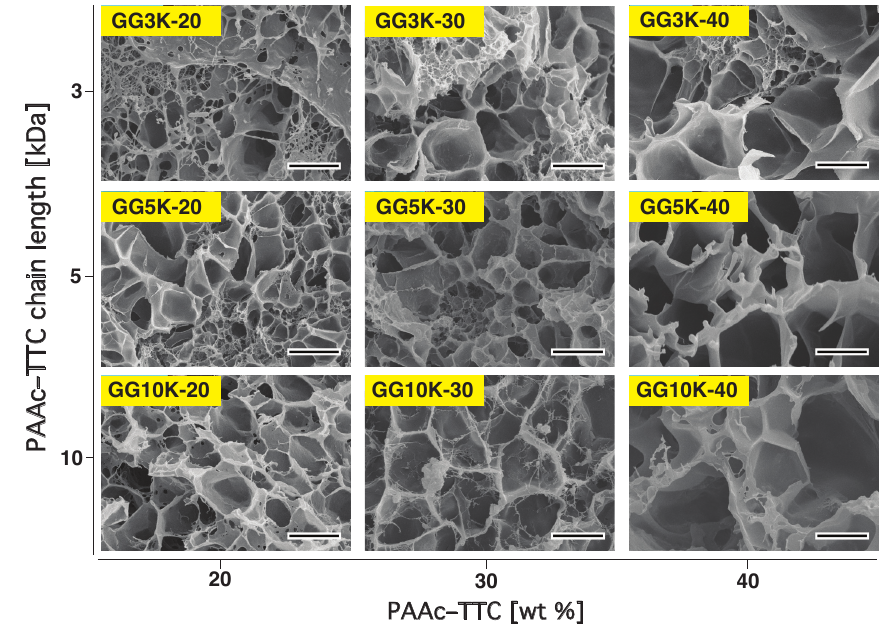
Figure 2. SEM images of the freeze-dried hydrogels with scale bars of 5 µ m.